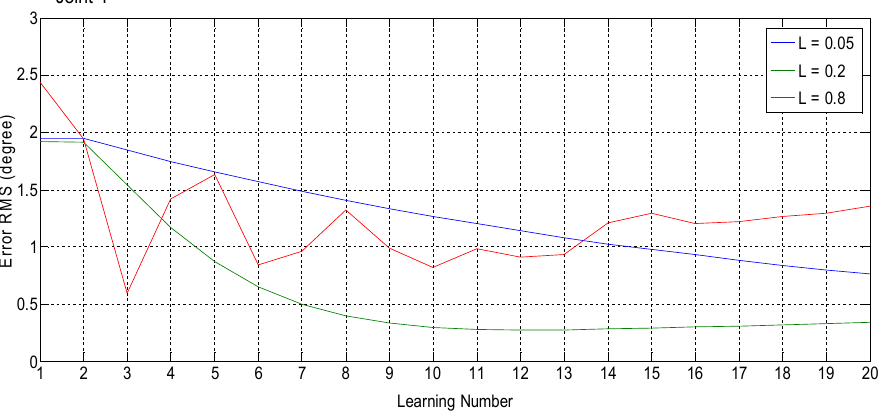
Figure 14. Convergence curves of RMSE with different learning rates under tracking experiment.